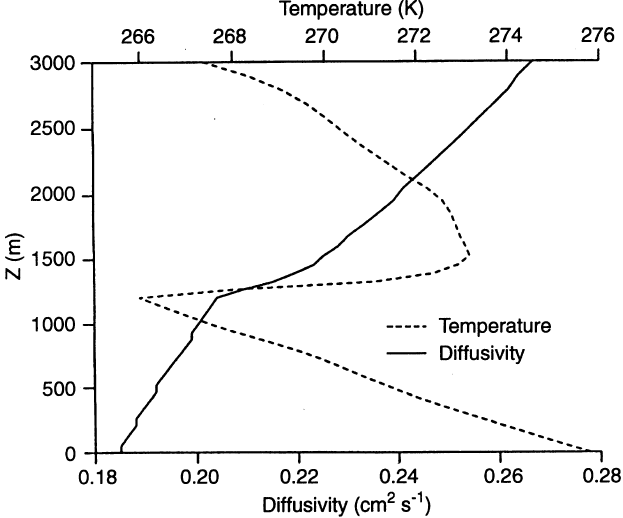
Fig. 5. Calculated di(cid:128)usivity profile of H 2 O using the Lennard-Jones model and the temperature profile from the LES model